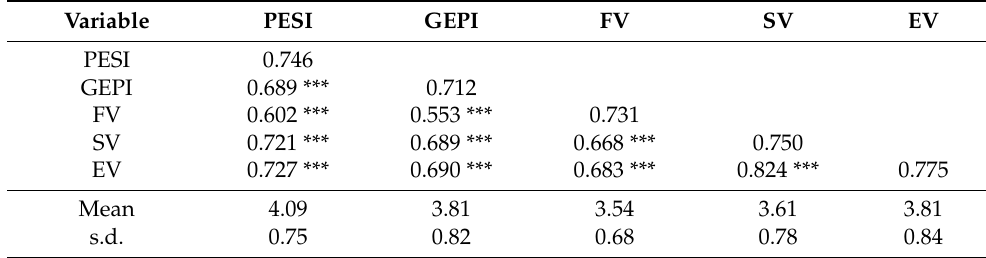
Table 3. Descriptive statistics, discriminant validity and correlations between